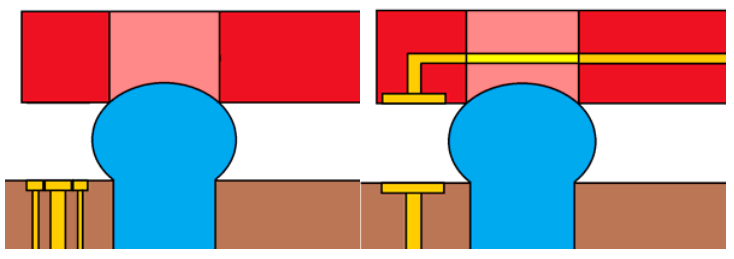
Figure 4. Capacitive probes in configurations using three capacitive probes between each droplet pair. The measure is achieved through an oscillator that is properly calibrated using the capacitance of air under the table as the oscillating capacitor. The frequency exciting the oscillator is then directly related to the